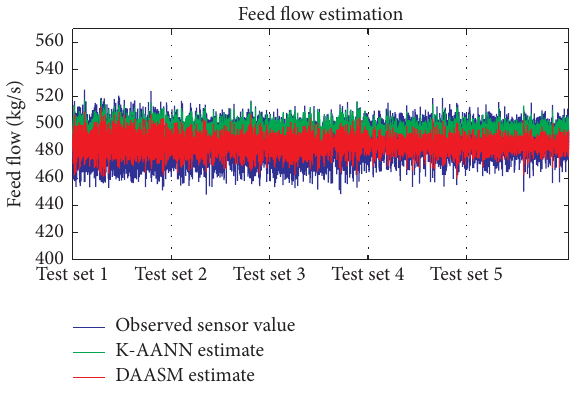
Figure 18: Feed flow